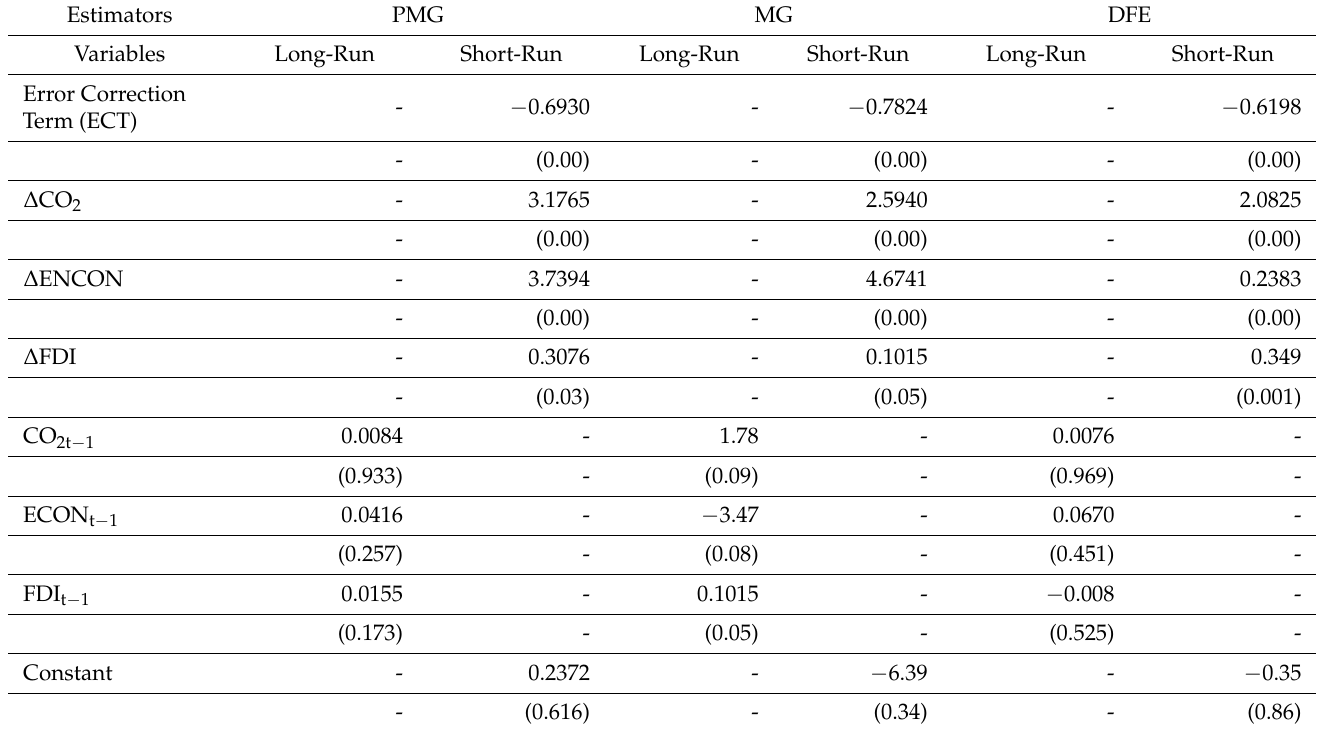
Table 5. PMG, MG, and DFE